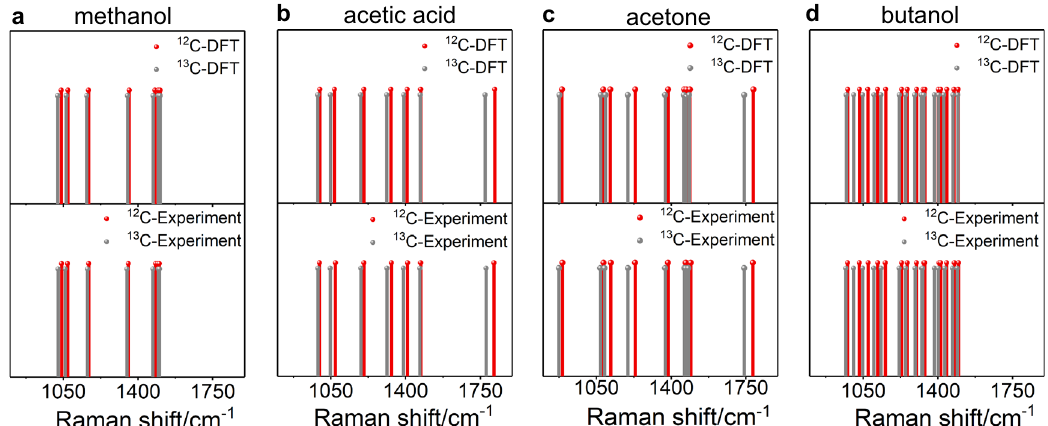
Fig. 3 Isotopological validation of CO 2 RR origin of surface species. Spectral barcodes for the DFT-computed Raman spectra (top row) and experimental SERS spectra (bottom row) for 12 C (red lines) and 13 C (gray lines) isotopologs of a methanol, b acetic acid, c acetone, and d butanol. Each vertical line in a barcode indicates the peak wavenumber of a vibrational mode. The number of SERS spectra that led to the experimental barcodes are a 119 and 43, b 106 and 59, c 243 and 177, and d 1062 and 836 for the 12 C and 13 C isotopologs, respectively. Source data are provided as a source data fi le.